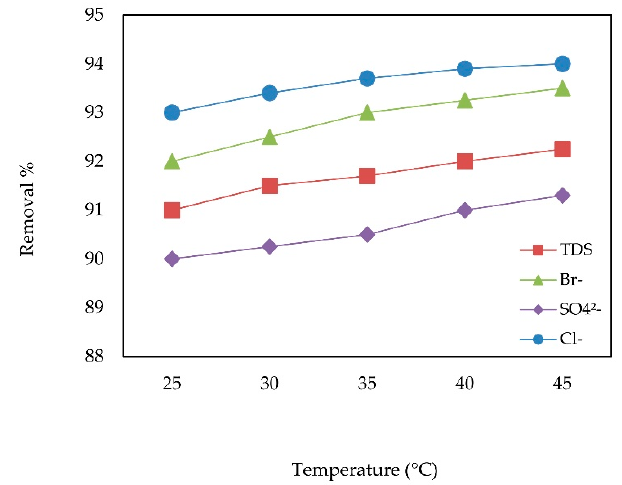
ff ect at optimal conditions (I = 2.0 mA / cm 2 , RT = 80 min, pH = Figure 6. Temperature effect at optimal conditions (I = 2.0 mA/cm 2 , RT = 80 min, pH = 8). Figure 6. Temperature e